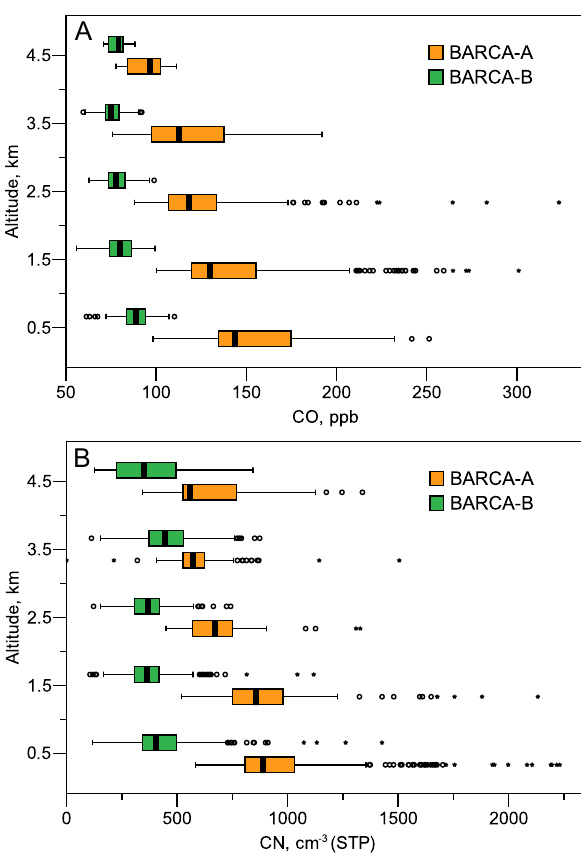
Fig. 8. Vertical profiles of CO mixing ratios (A) and CN number concentrations (B) during BARCA-A (excluding the smoky region) and BARCA-B. The center line in the bar-and-whisker plots repre- sents the medians, the boxes show the upper and lower quartiles, the whiskers show the expected range, and the symbols represent outliers and extreme values (as defined by SPSS).